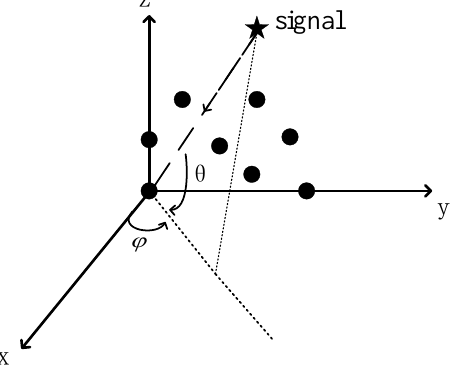
Figure 2. Reconfigurable antenna array.